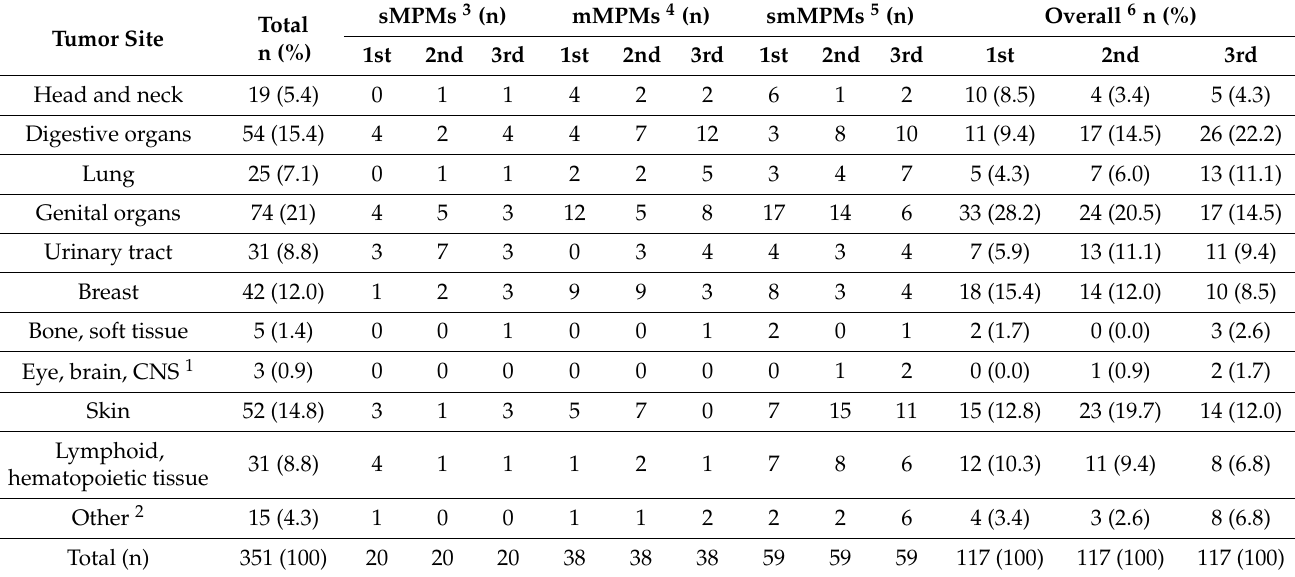
Table 6. Tumor site distribution based on the time of tumor